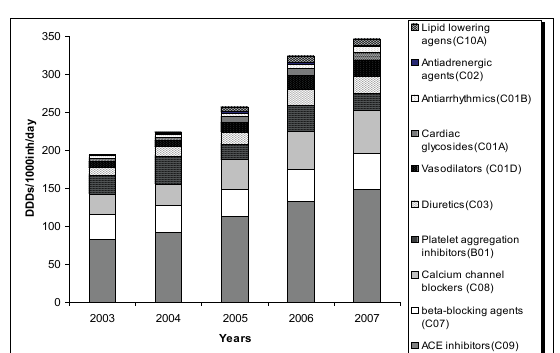
Figure 2. Relative standard deviation (RSD) per cardiovascular drug